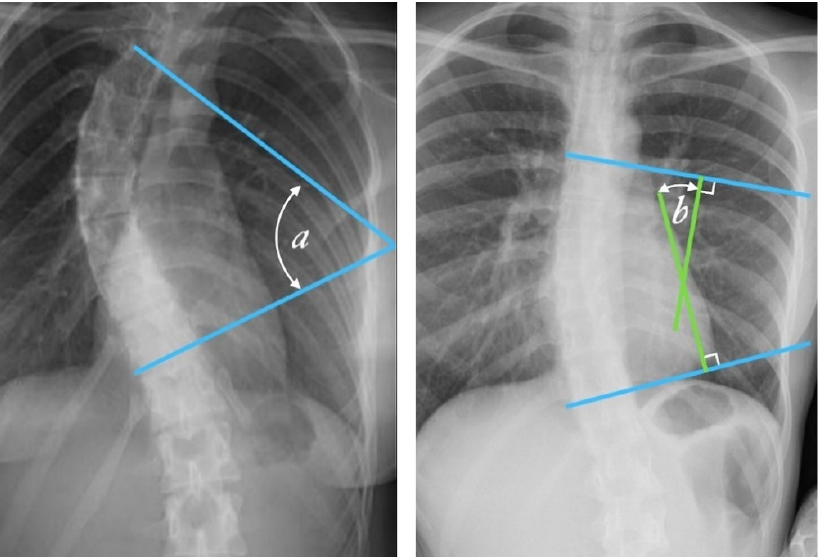
Figure 2. Cobb angle measurement. Tangential lines are drawn from the superior endplate of the superior vertebra and the inferior endplate of the inferior vertebra. The angle formed at the intersection of these two lines is the Cobb angle. A Cobb angle of at least 10 degrees is necessary for diagnosing scoliosis. (Case courtesy of Assoc Prof Frank Gaillard, Radiopaedia.org, rID: 49374, (CC BY 3.0).) [14] The Cobb angle is defined either as the angle between the tangential lines (angle a) or the angle between two lines drawn perpendicular (solid lines) to the tangents (angle b).